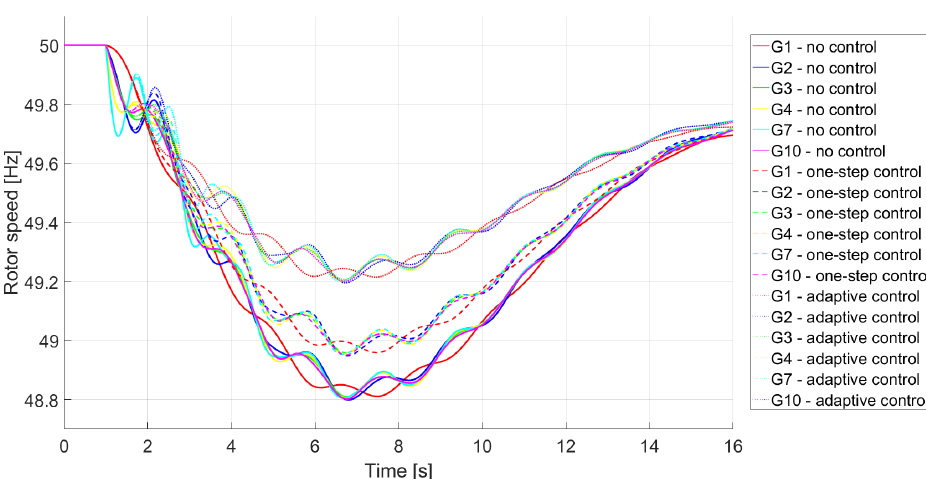
Figure 10. Generators’ rotor speed in Configuration I in case of big